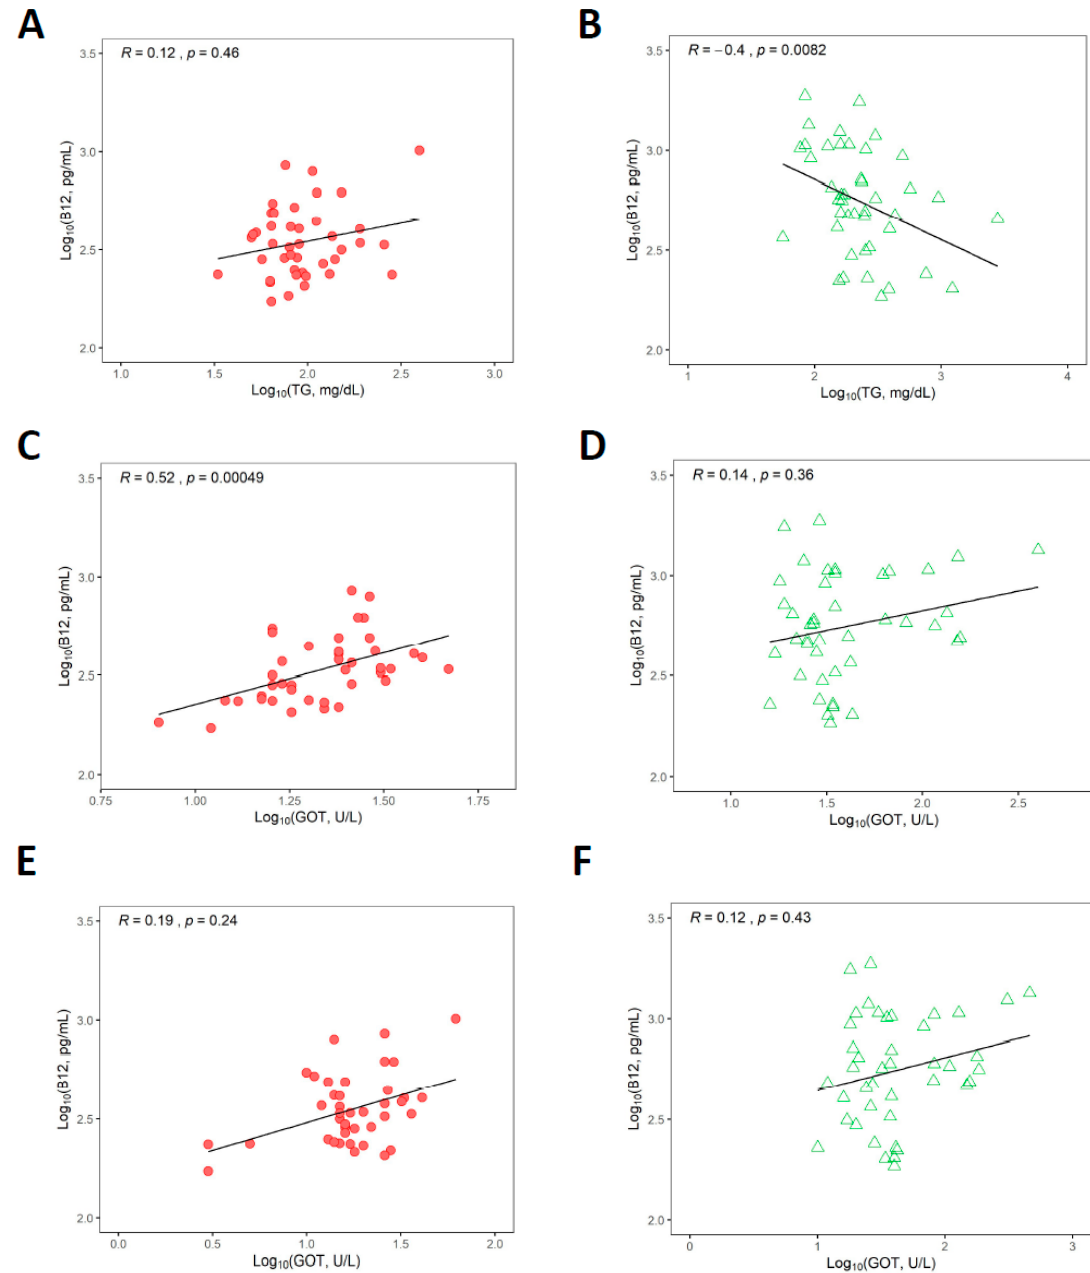
Figure 3. Correlation analysis (Spearman method) of log10-transformed biomarker datasets. Panel ( A ) B 12 and TG in healthy controls; Panel ( B ) B 12 and TG in GSD patients; Panel ( C ) B 12 and GOT in healthy controls; Panel ( D ) B 12 and GOT in GSD patients; Panel ( E ) B 12 and GPT in healthy controls and Panel ( F ) B 12 and GPT in GSD patients. Rho values for these correlations are provided in Table 5. Statistically significant associations were found for log10 B 12 versus log10 TG in GSD patients, and for log10 B 12 versus log10 GOT in the healthy control group.